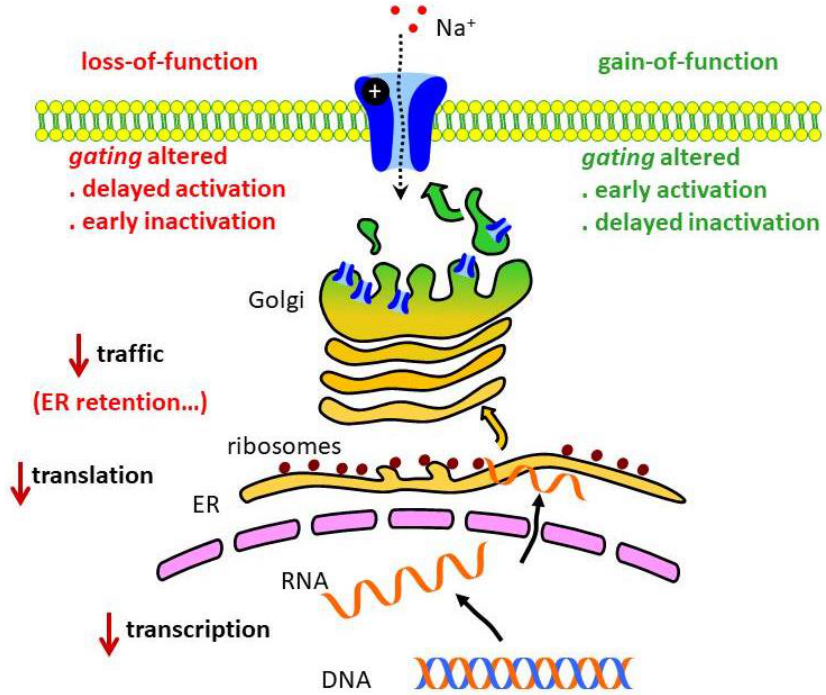
Figure 2. Alterations in the Na V channel associated with heart disease. Several molecular mechanisms can affect expression, localization or function of the channel and are associated with inherited or acquired heart disease. ER, endoplasmic reticulum.